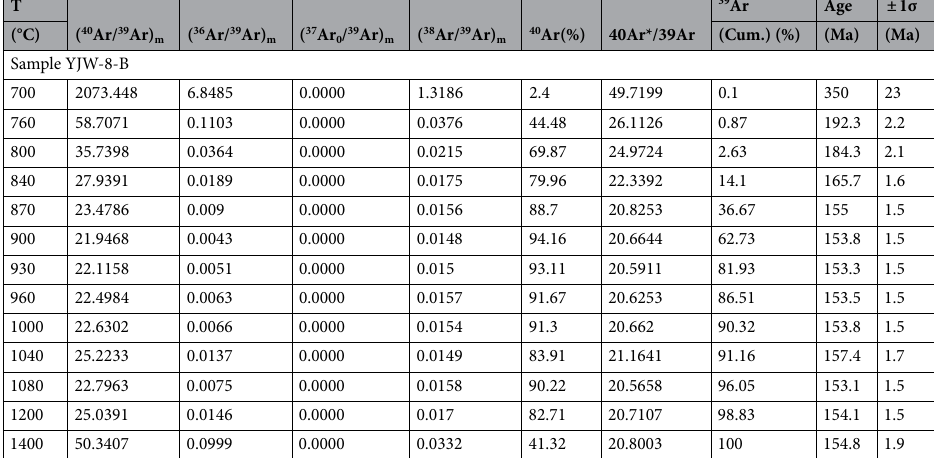
Table 4. Ar–Ar stepwise heating data for muscovite samples from the QGC and the Shizhuyuan